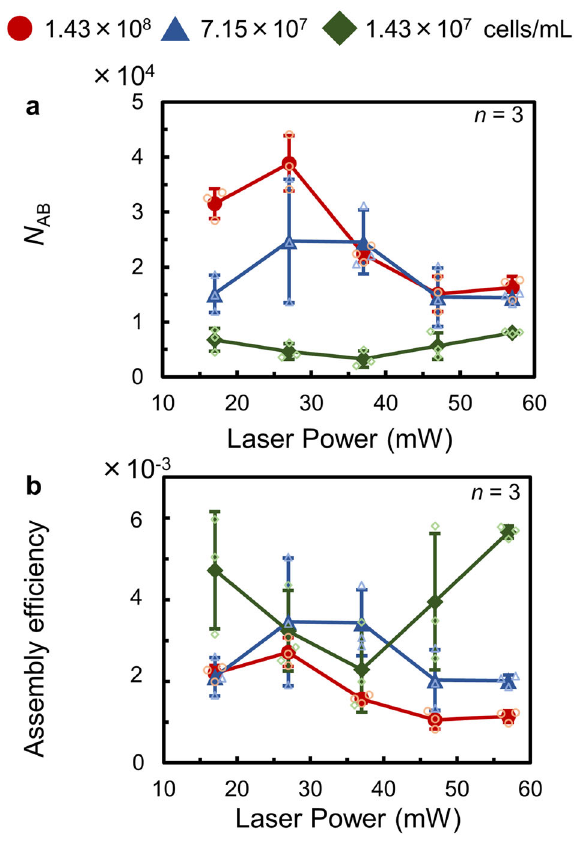
Fig. 3 Relationship between the laser power and number of assembled bacteria ( N AB ) or assembly ef fi ciency at each bacterial concentration studied. a Dependence of N AB on laser power ( n = 3 independent experiments). b Dependence of the assembly ef fi ciency of the bacteria on laser power ( n = 3 independent experiments). The error bars represent the standard deviation. Individual values are shown as small plots. ef fi ciency, which is N AB over the total number of bacteria in the dispersion liquid. The assembly ef fi ciency was found to be inver- sely proportional to the concentration of bacteria, indicating that the dispersoids can be trapped more ef fi ciently at a low con- centration. Thus, bacterial assembly can be achieved even at a low initial concentration of bacteria in the dispersion liquid.